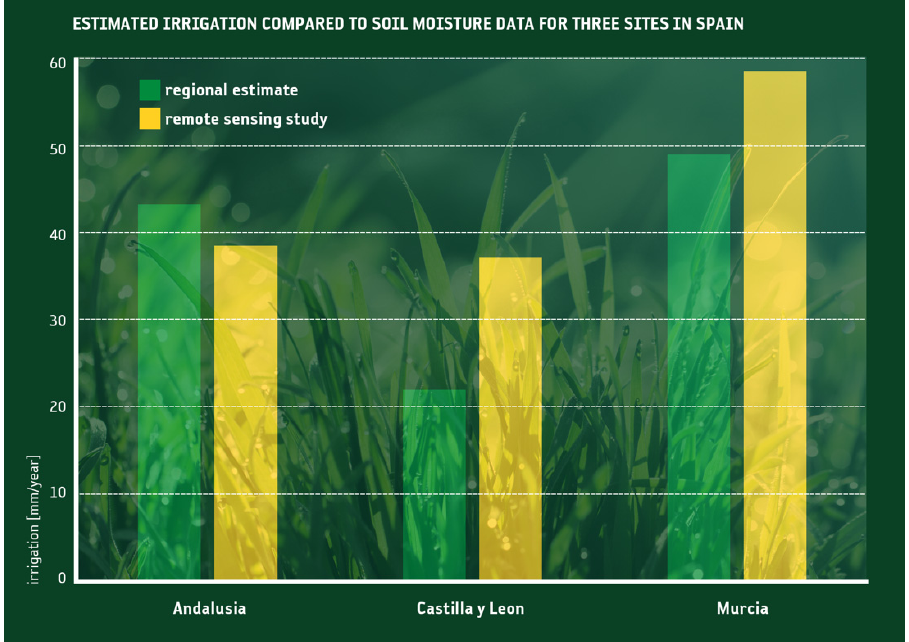
Figure 2. Comparison of observed (statistical survey) and estimated (through satellite soil moisture) annual irrigation volumes for three regions in Spain (adapted from Brocca et al. [97]).